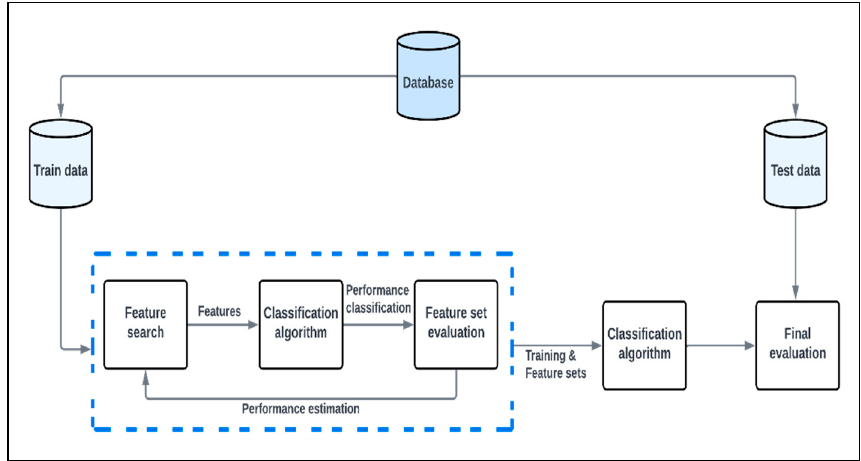
Figure 1. Wrapper-based feature selection framework.